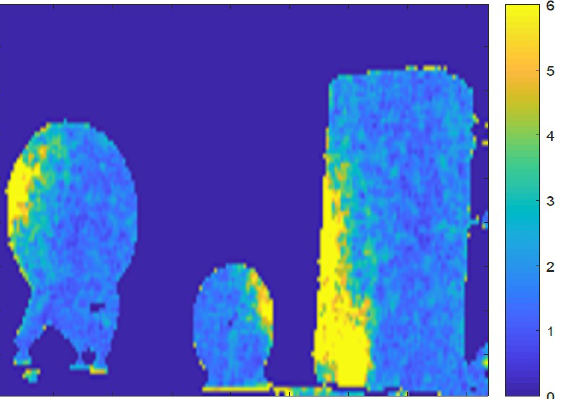
Figure 15. Example of detecting inconsistency in a scene based on scene illumination. A scene with 3 objects is captured using a depth camera. The noise image of the scene shows larger noise values on the right of the middle object and on the left of the other two